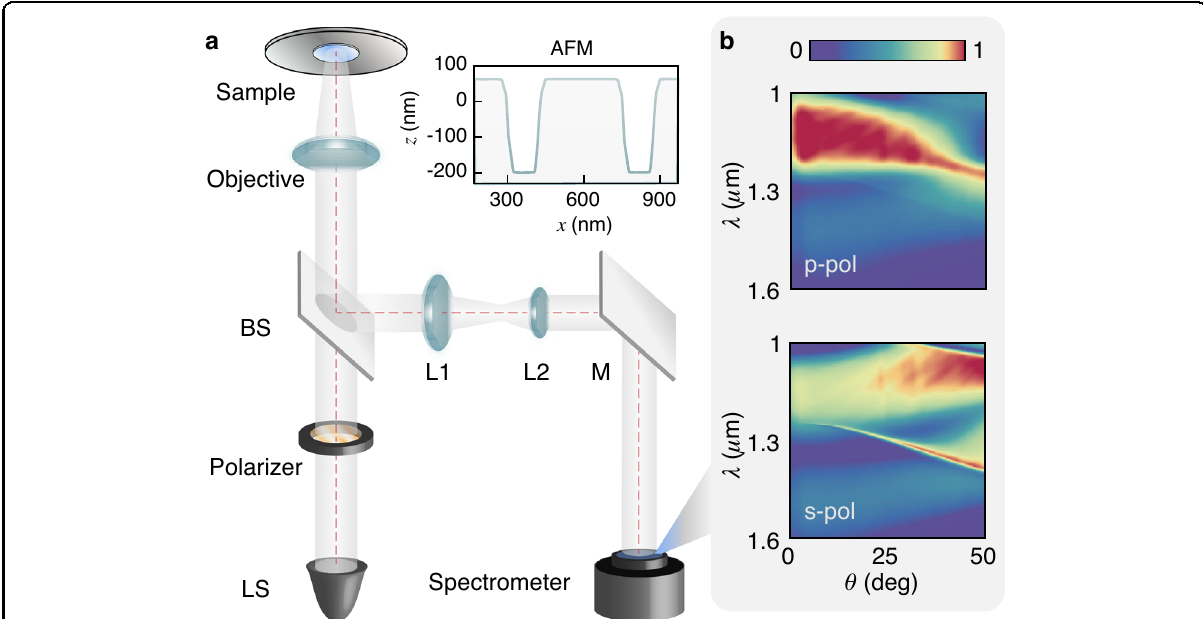
Fig. 3 Experimental setup and measured results of an SOI grating. a Schematic layout of the home-made ARS. Sample pro fi le of the grating in the top inset. BS beam splitter, L1, L2 lenses, M mirror, LS light source. b Dispersions of the sample measured as angle-resolved re fl ectance (R)